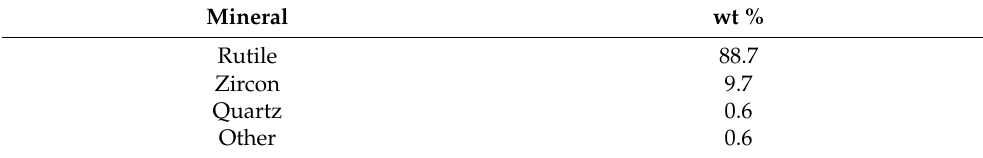
Table 3. Mineralogical composition of rutile concentrate from MS 5A.